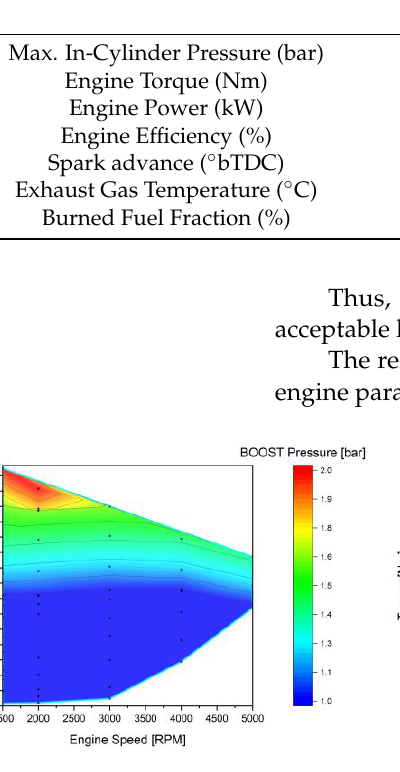
Figure 10. Boost level, engine efficiency, and spark advance as a function of engine speed and torque.